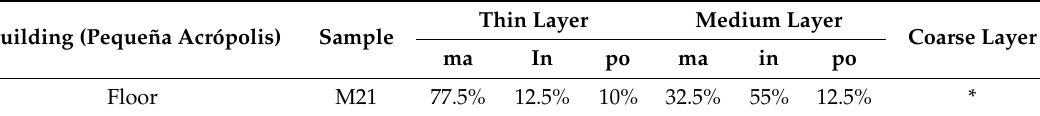
Table 10. Average frequency of inclusions in all the layers of Type 4 plasters. Average frequency of inclusions in all the layers of Type 1 plasters. mi (micritic inclusions); hi (heterogeneous inclusions); si (sparitic inclusions); c (clays); cb (carbon); ch (chert); sh (shells); vt (vegetal tissue); s (soil). 1—very scarce (less than 5%); 2—scarce (5%–15%); 3—common (15%–40%); 4—frequent